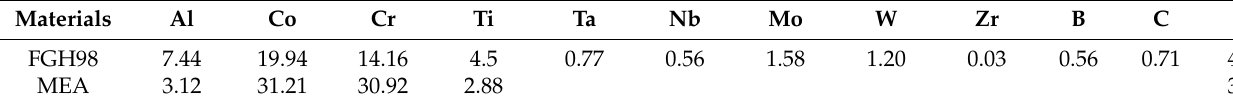
Table 1. The composition of FGH98 and Al 3 Ti 3 (CrCoNi) 94 (at, %).